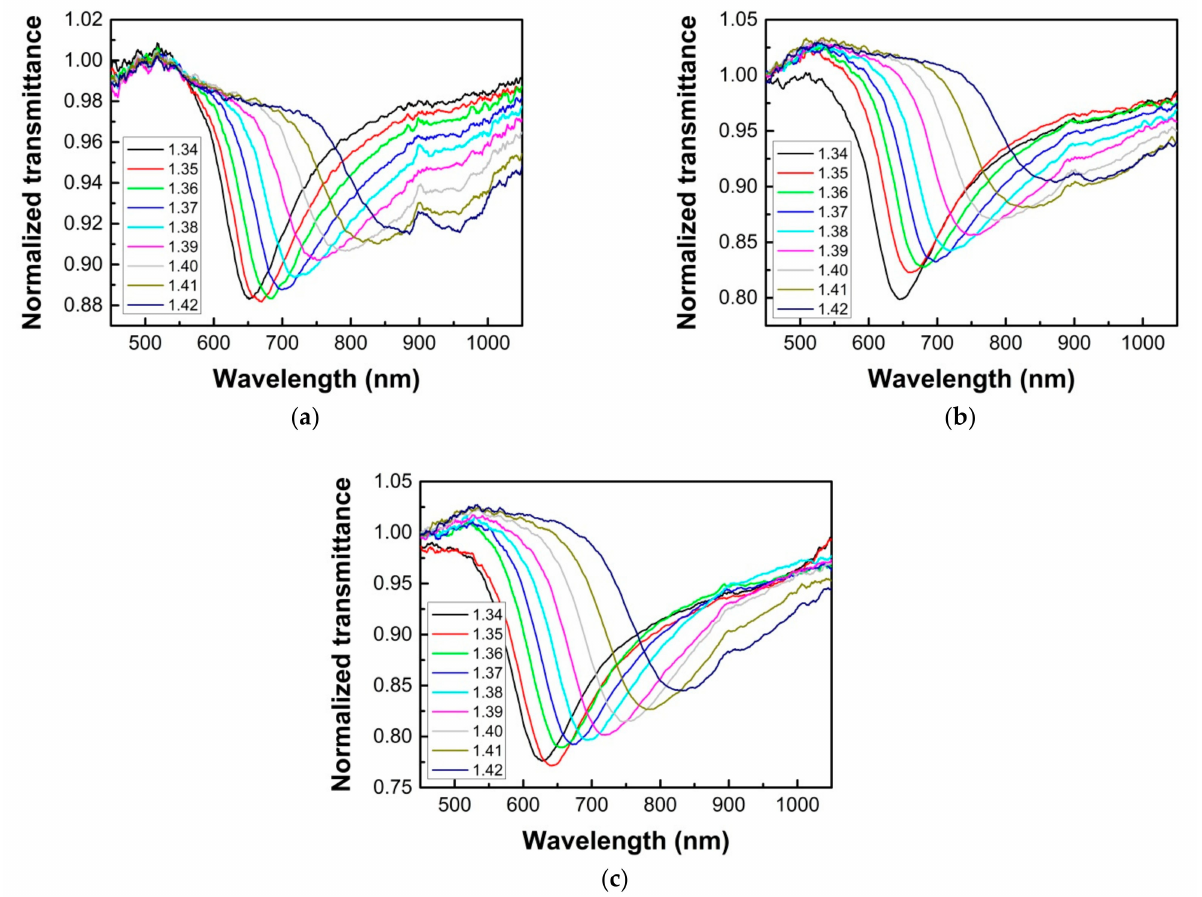
Figure 9. The SPR transmission spectra in glycerol–water solutions with different RIs for the single-sided polished SPR probe with polished depths of 200 µ m ( a ) and 400 µ m ( b ), and the double-sided polished SPR probe with a polished depth of 200 µ m ( c ).